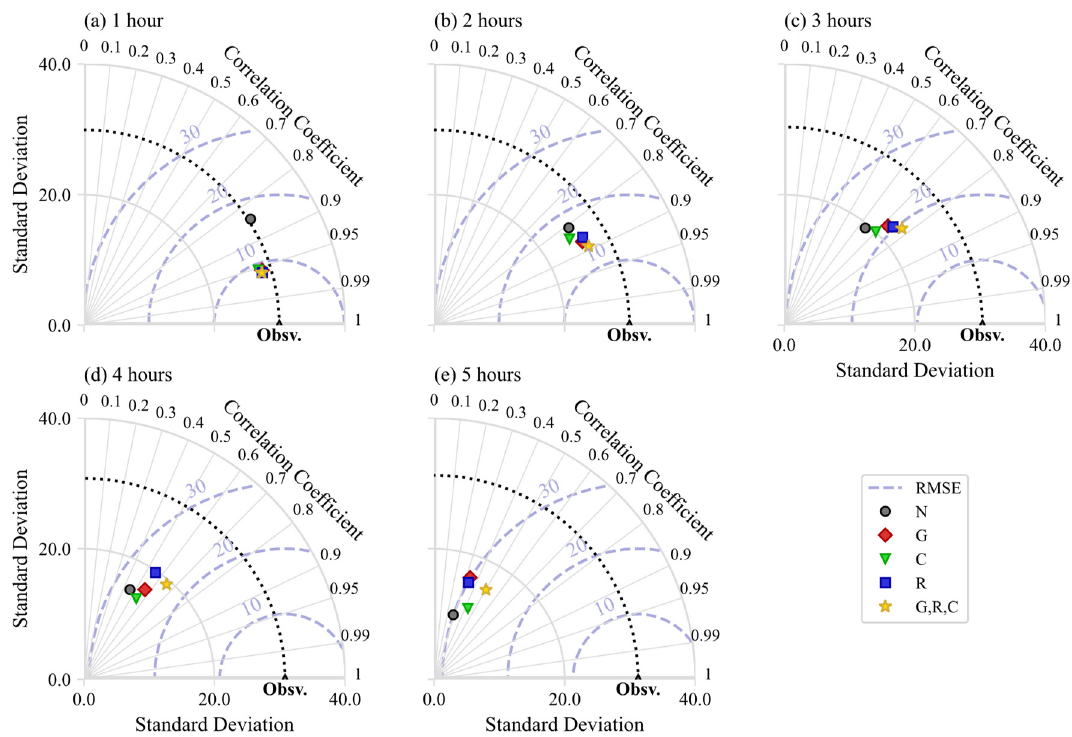
Figure 9. Taylor diagrams for the ELM models with different QPE products in their feature set at forecasting lead times ranging from 1 to 5 h ( a – e ).